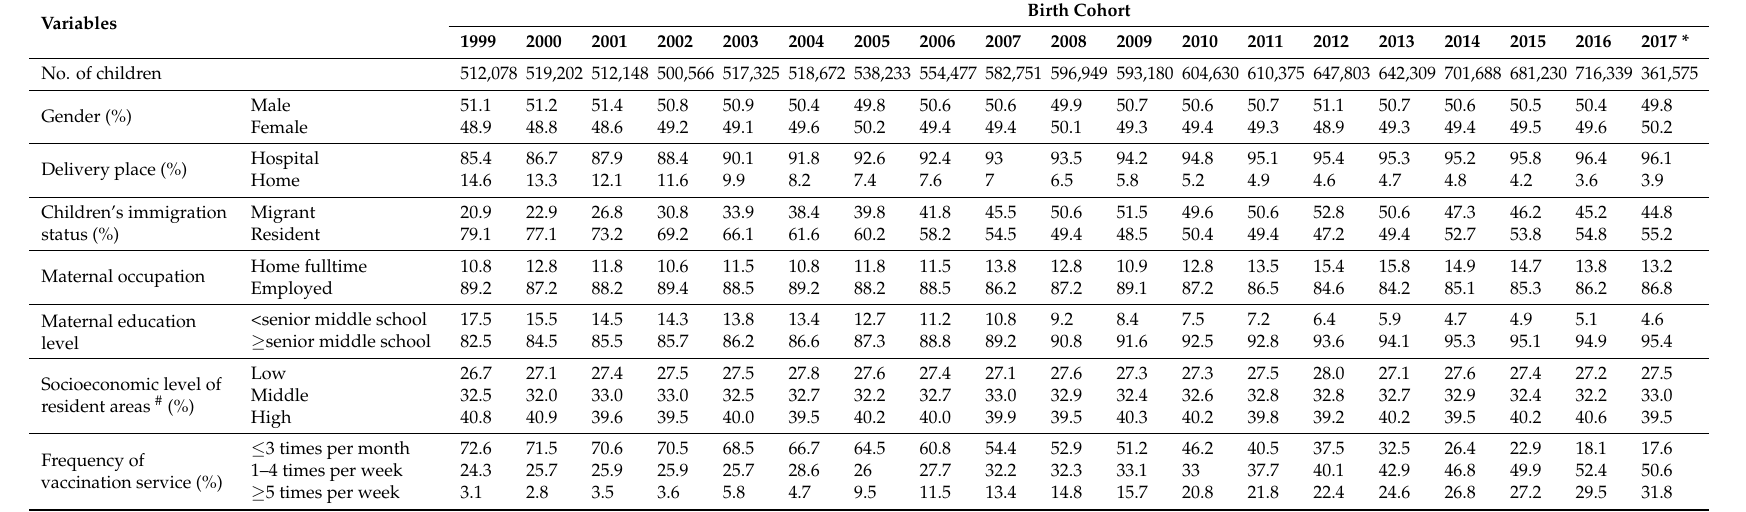
Table 1. The demographic characteristics of birth cohorts from 1999 to 2017, Zhejiang